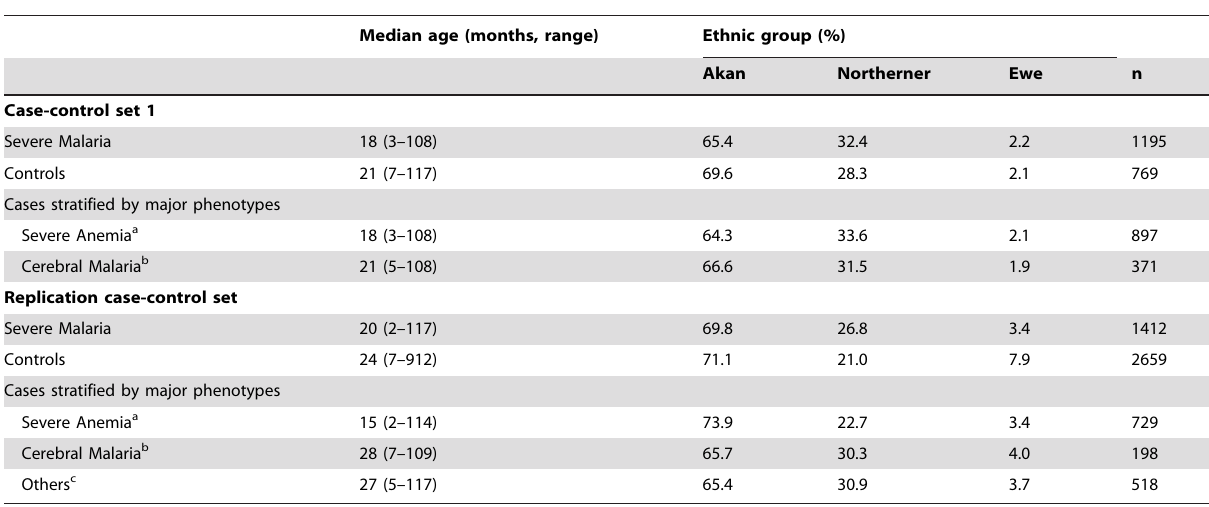
Table 2. Characteristics of severe malaria case-control sample